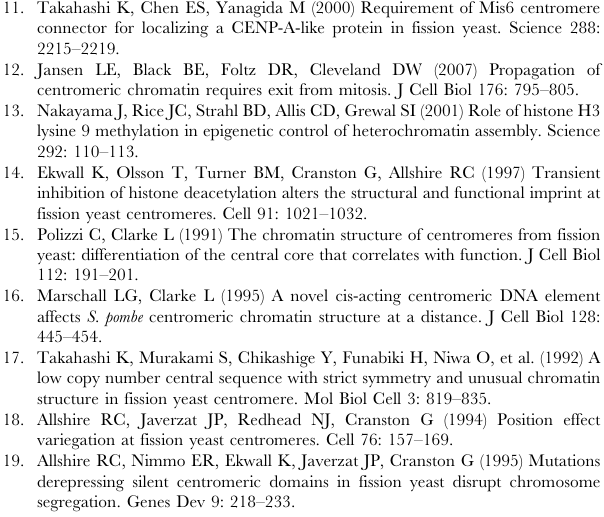
chore domain. ChIP was performed using antibody against C-